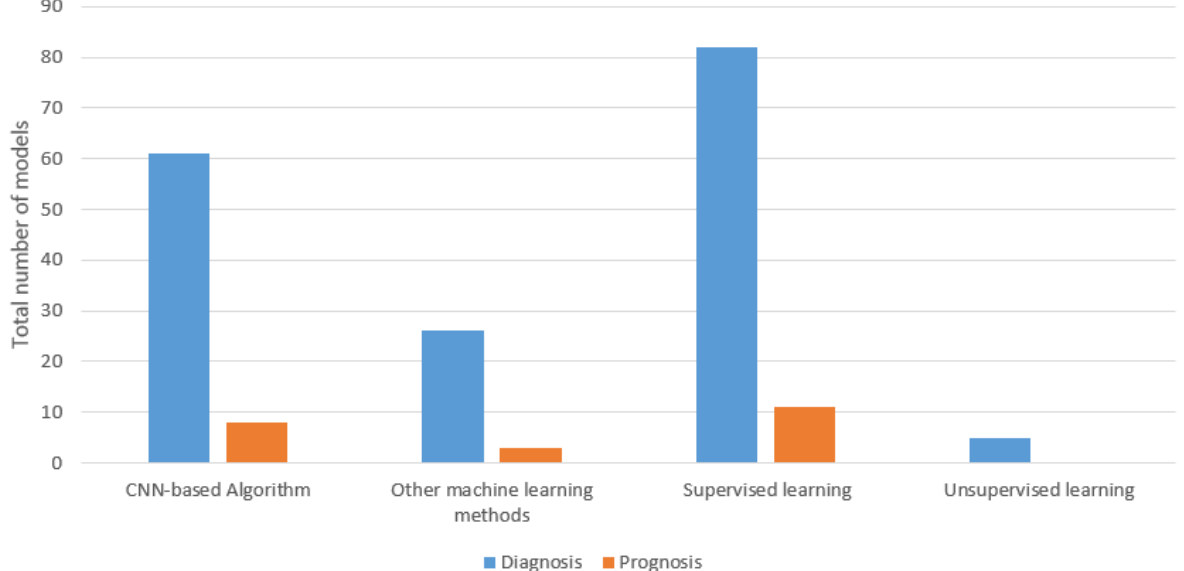
Figure 2. Number of deep learning and other machine learning methods used in the reviewed studies. CNN: convolutional neural network.